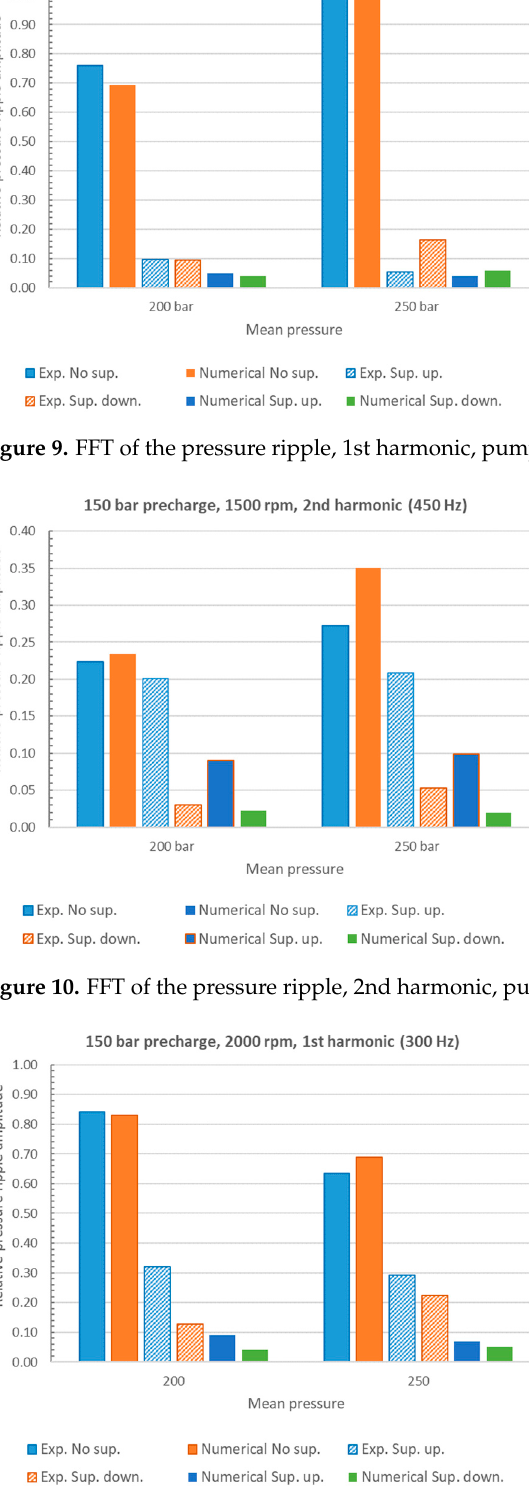
Figure 11. FFT of the pressure ripple, 1st harmonic, pump speed = 2000 rpm.